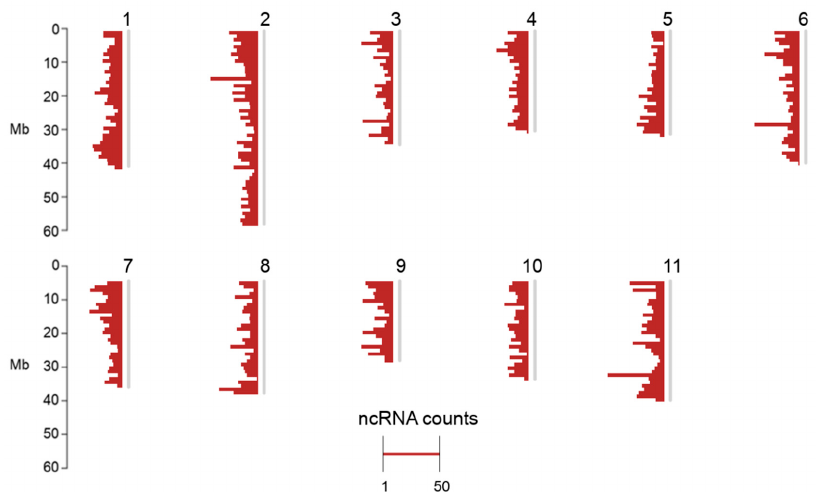
Figure 1. Distribution of ncRNAs in Coffea canephora genome.